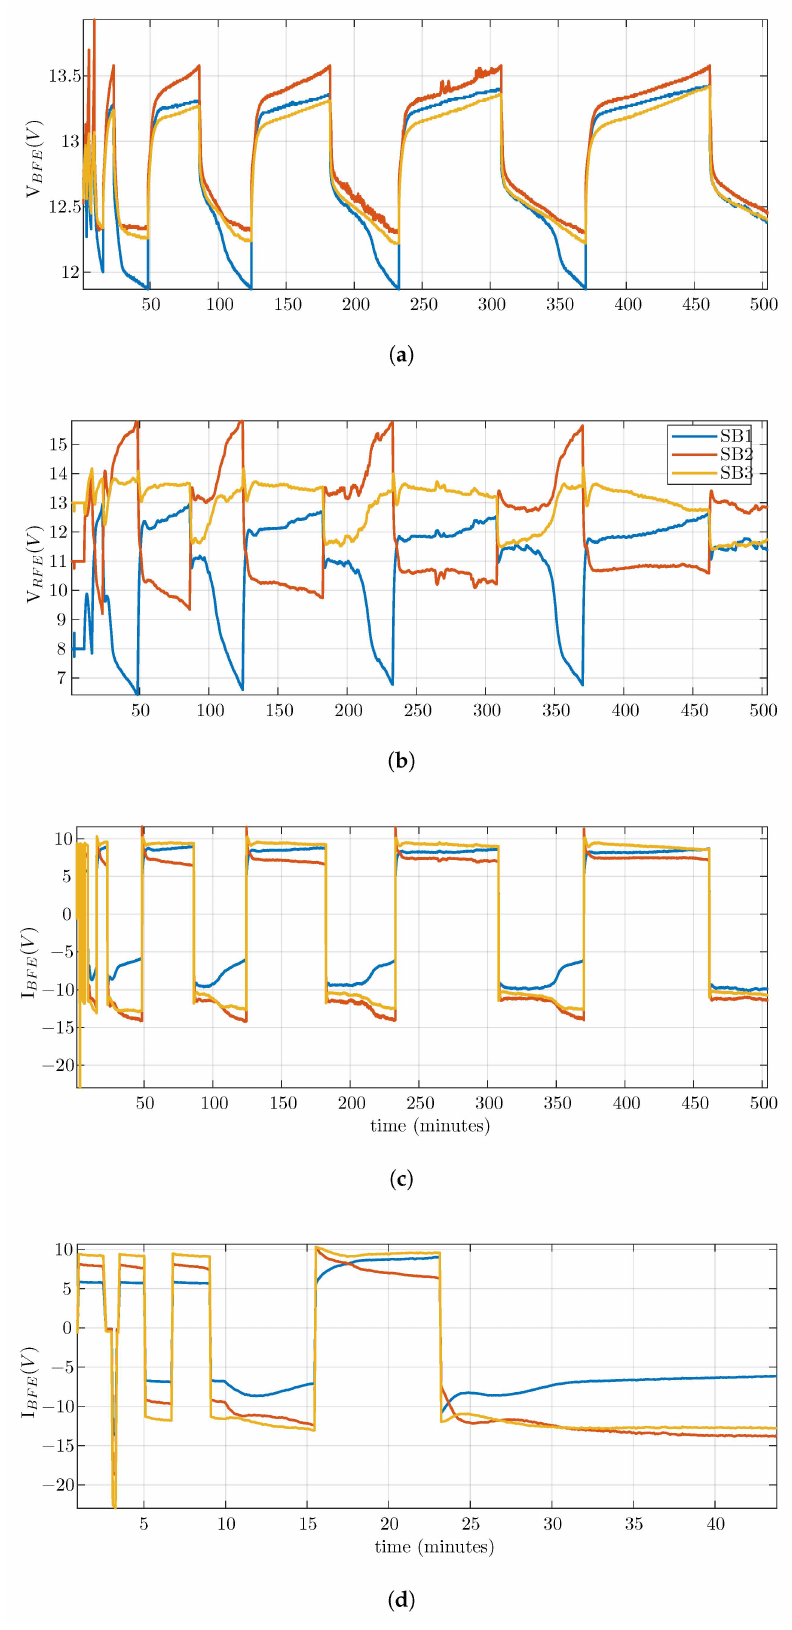
Figure 12. Experimental results with three SB modules in series being charged and discharged: ( a ) BFE voltages; ( b ) RFE voltage; ( c ) BFE current; ( d ) BFE currents during the initial cycles with the active balancing disabled (t < 10